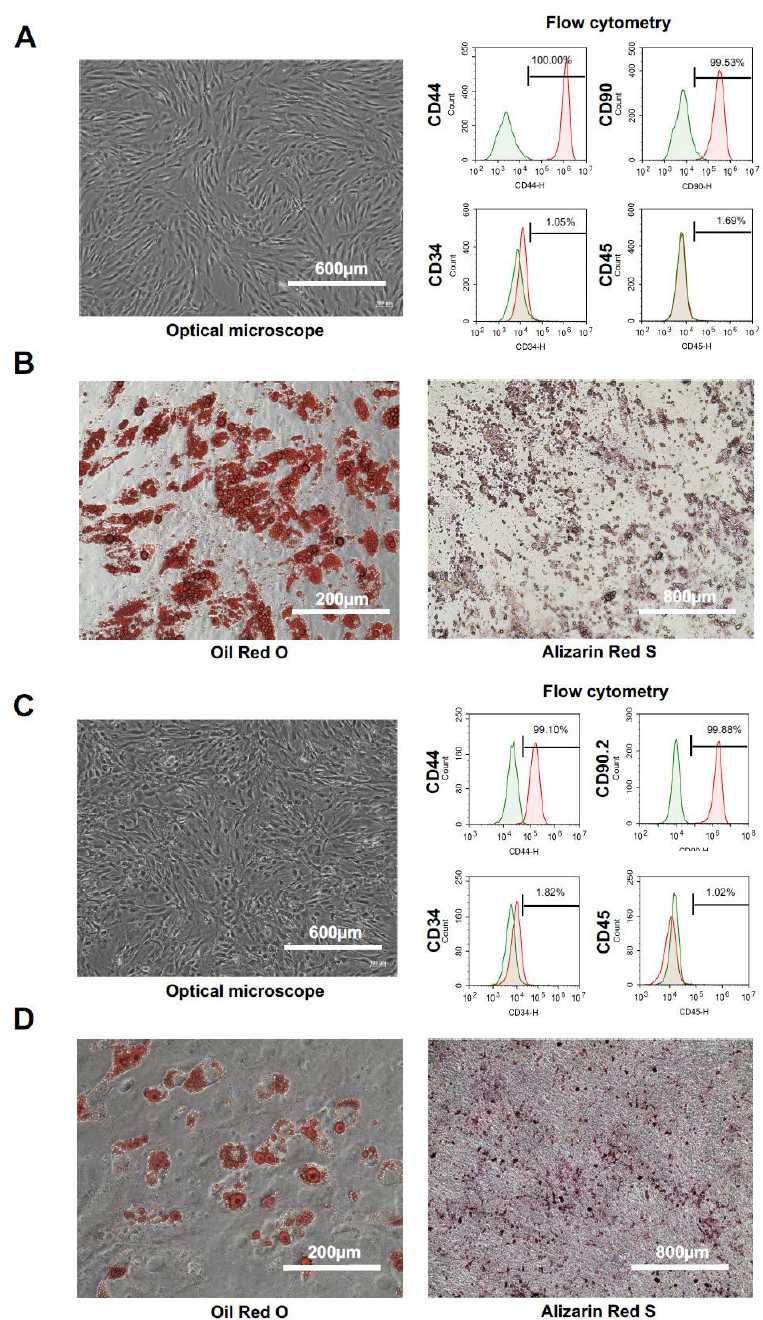
Figure 1. The phenotype and differentiation potential of hADSCs and mADSCs in culture. The morphological appearance of hADSCs (passage 3) ( A ), (left panel). The characterization of hADSCs (passage 3). The characterization of hADSCs was performed by flow cytometry using antibodies against CD34, CD44, CD45, and CD90. hADSCs were positive for CD44, and CD90, but negative for CD34 and CD45 ( A ), (right panels). Representative images of adipocyte ( B ), (left panel) and osteocyte differentiation ( B ), (right panel) from hADSCs (passage 3) cultured in differentiation medium. The morphological appearance of mADSCs (passage 3) ( C ), (left panel). The characterization of mADSCs (passage 3). The characterization of mADSCs was performed by flow cytometry using antibodies against CD34, CD44, CD45, and CD90.2. mADSCs were positive for CD44, and CD90.2, but negative for CD34 and CD45 ( C ), (right panels). Representative images of adipocyte ( D ), (left panel) and osteocyte differentiation ( D ), (right panel) from hADSCs (passage 3) cultured in differentiation